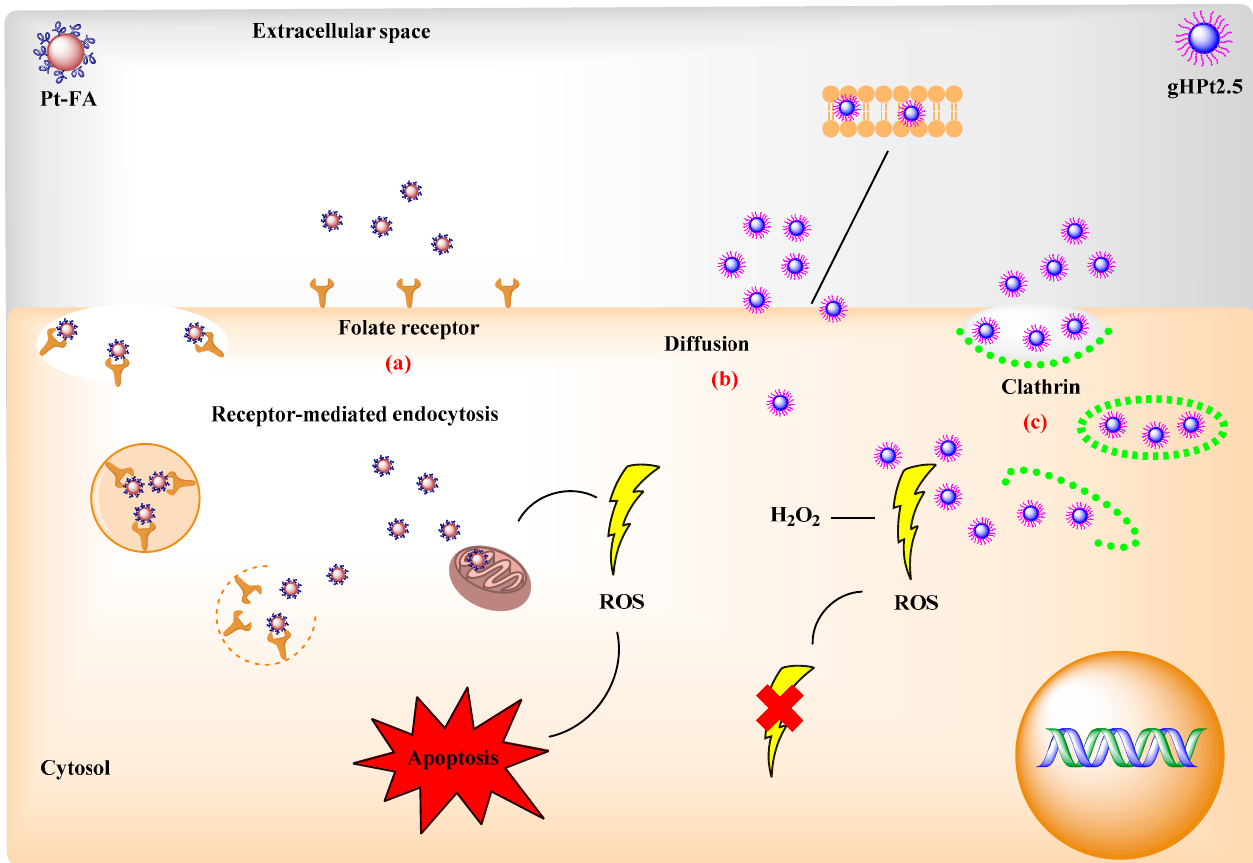
Figure 3. The methods of PtNPs uptake into a cell. ( a ) Folate-receptor-mediated endocytosis. ( b ) Diffusion. ( c ) Clathrin-mediated endocytosis.